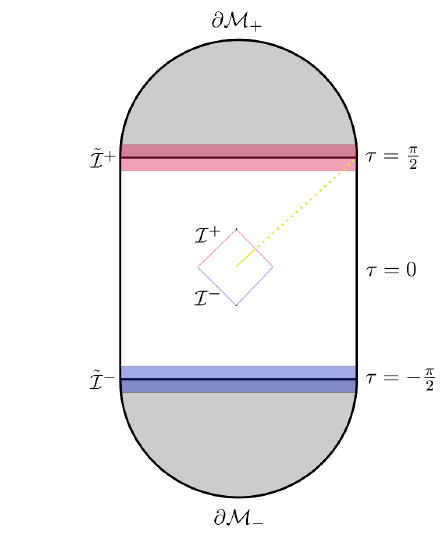
˜ I ± around , while spatial infinity i is ± 0